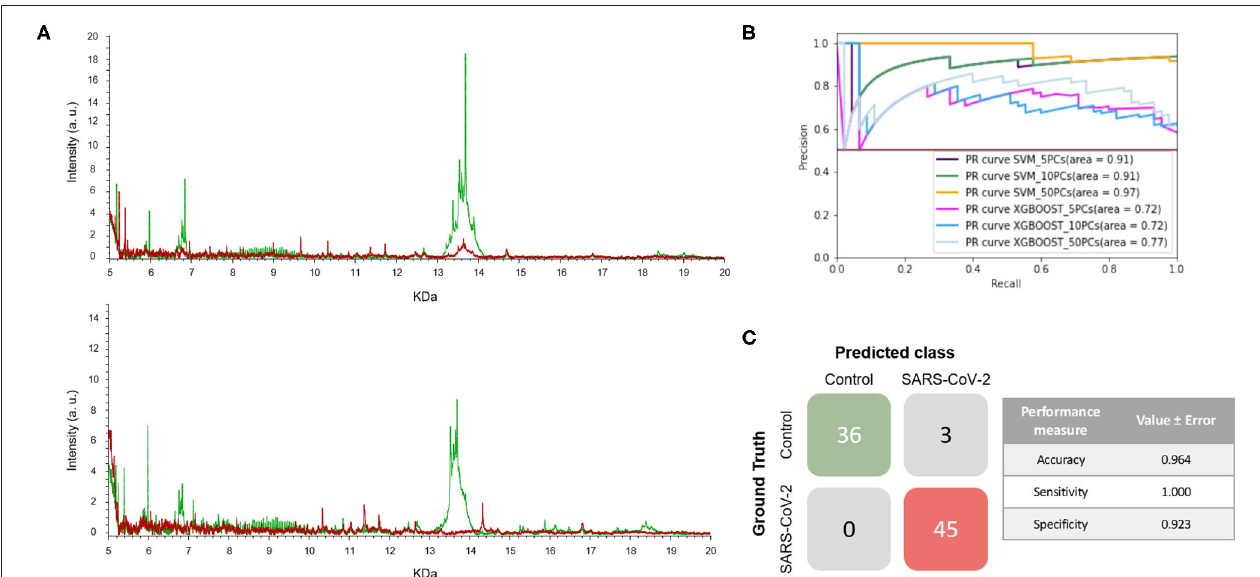
FIGURE 5 | Developed methodology robustness. (A) Representative mass spectra of NP samples [positive (red) and negative (green)] for SARS-CoV-2 of S1 (top mass spectra) and S2 (down mass spectra). (B) Precision-recall curve from the different models. (C) Matrix confusion showing the summary of the results of all the samples used in the test phases and performance measures of the best model (SVM + 5PCs cross-validation K = 10). Note that no errors are included given that the results correspond to a single test